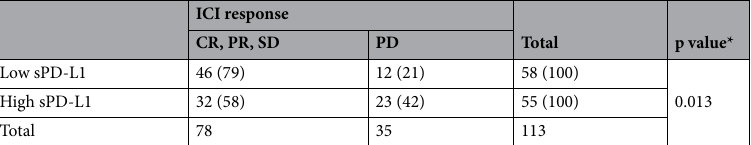
Table 2. Response according to pretreatment sPD-L1 levels. Response was evaluated in 113 patients. The results are presented as total numbers (percentages). sPD-L1 soluble programmed death ligand-1, ICI immune checkpoint inhibitor, CR complete response, PR partial response, SD stable disease, PD progressive disease. *Significance at p < 0.05 ( χ 2